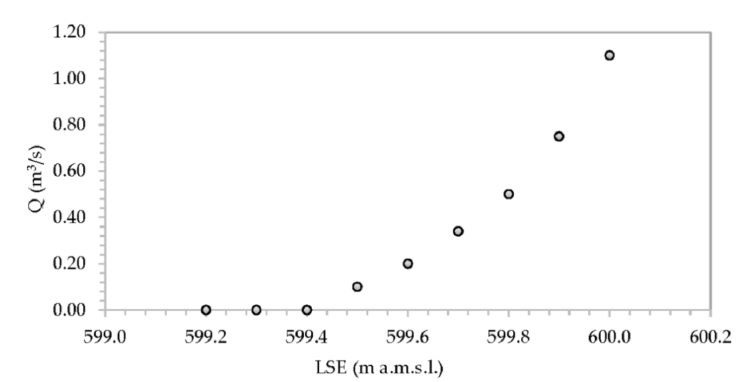
Figure 6. Q/LSE relation of crested weir at the outlet of Zazari